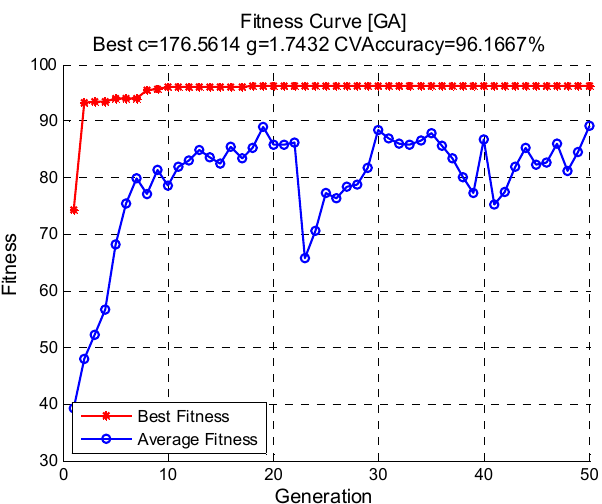
Figure 13. Fitness curve with GA.